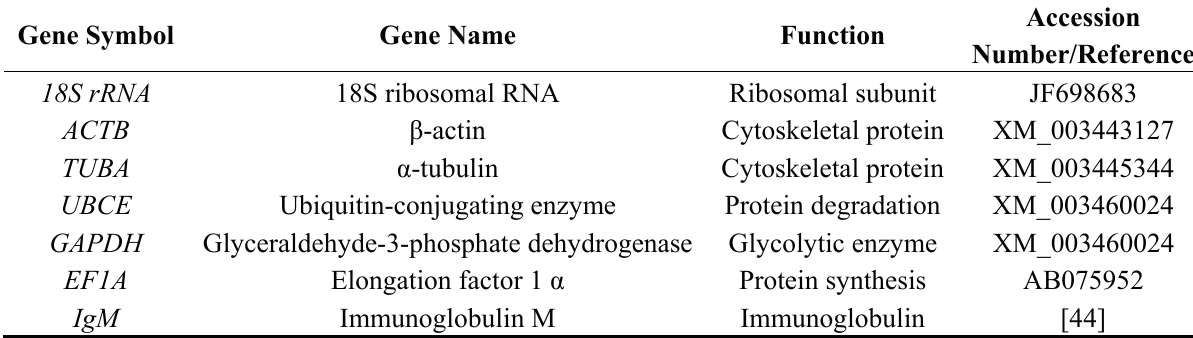
Table 5. Candidate reference genes and target gene used in this